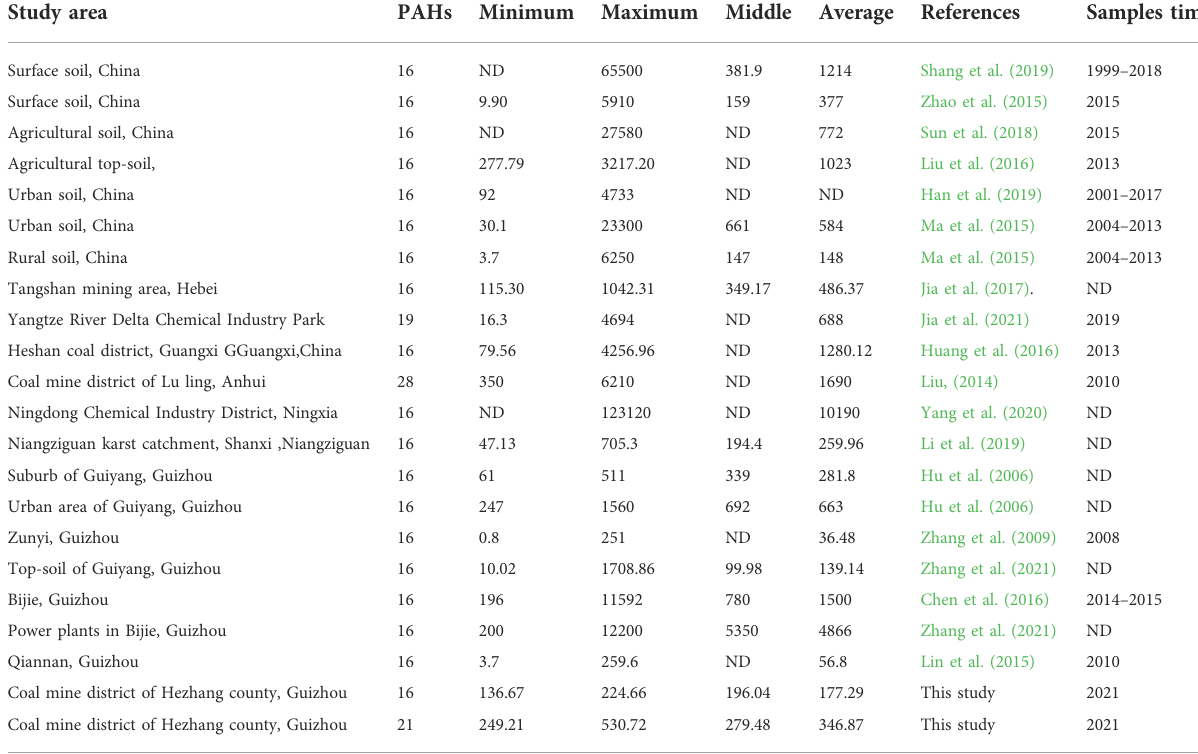
TABLE 6 Concentrations of PAHs in surface soils from different areas in China. Study area PAHs Minimum Maximum Middle Average References Samples